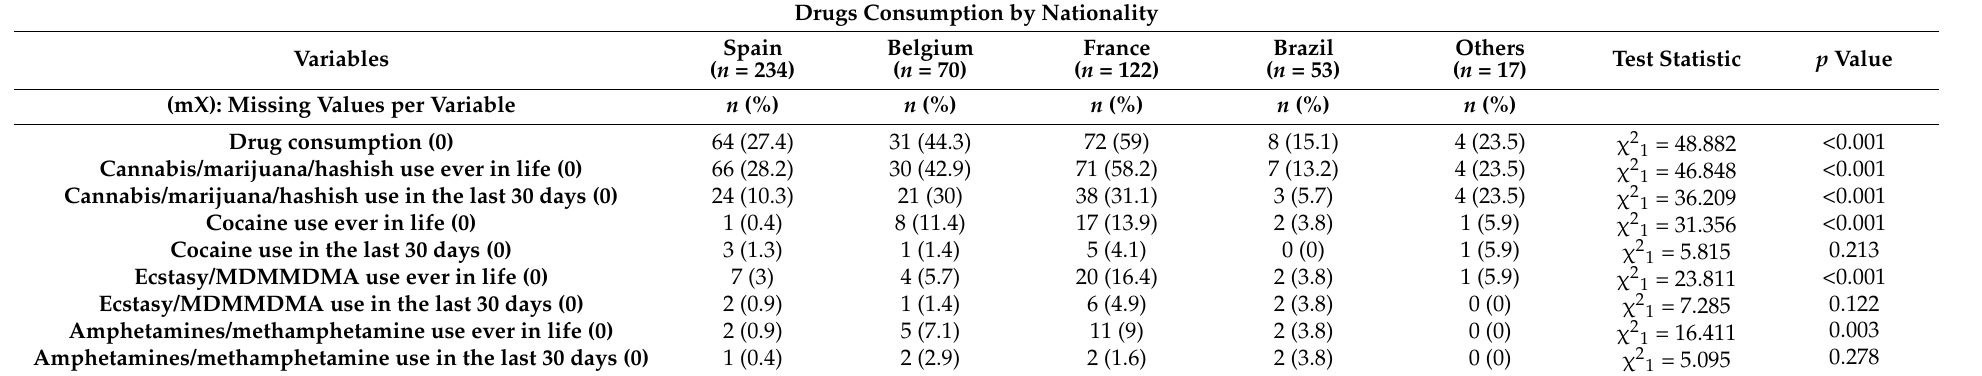
Table 5. Illicit drug use by nationality.